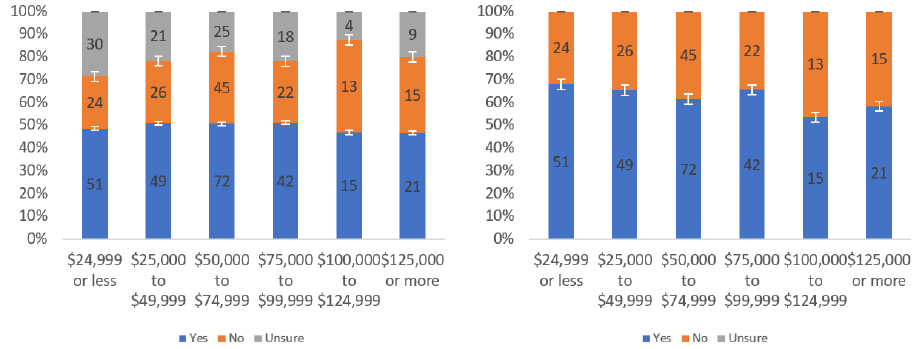
Figure A13. Responses regarding usefulness in judging trustworthiness by income level including ( left ) and excluding ( right ) unsure responses.